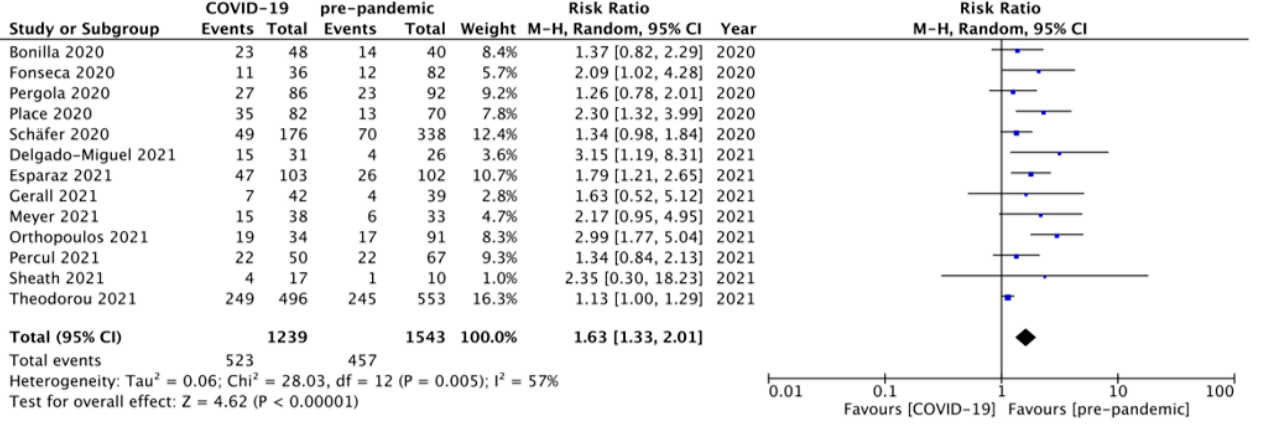
Figure 2. Forest plot comparison of the incidence of complicated appendicitis between the two groups of patients, i.e., presenting during the COVID-19 pandemic versus the pre-pandemic period. COVID—Coronavirus Disease 2019. M-H—Mantel–Haenszel method; CI—confidence interval.